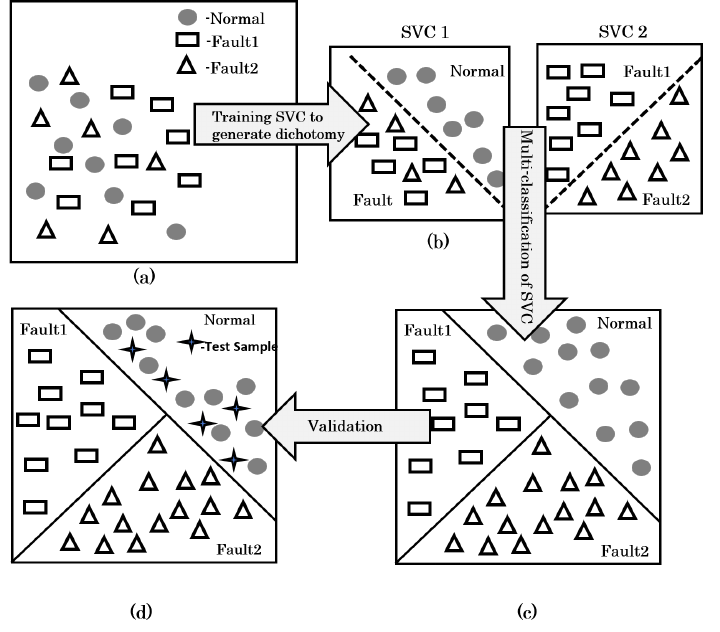
Figure 2. Diagnosis process using SVC in phases: ( a ) data collection stage, ( b ) training and learning phase, ( c ) multi-classifier integration phase, and ( d ) test/validation